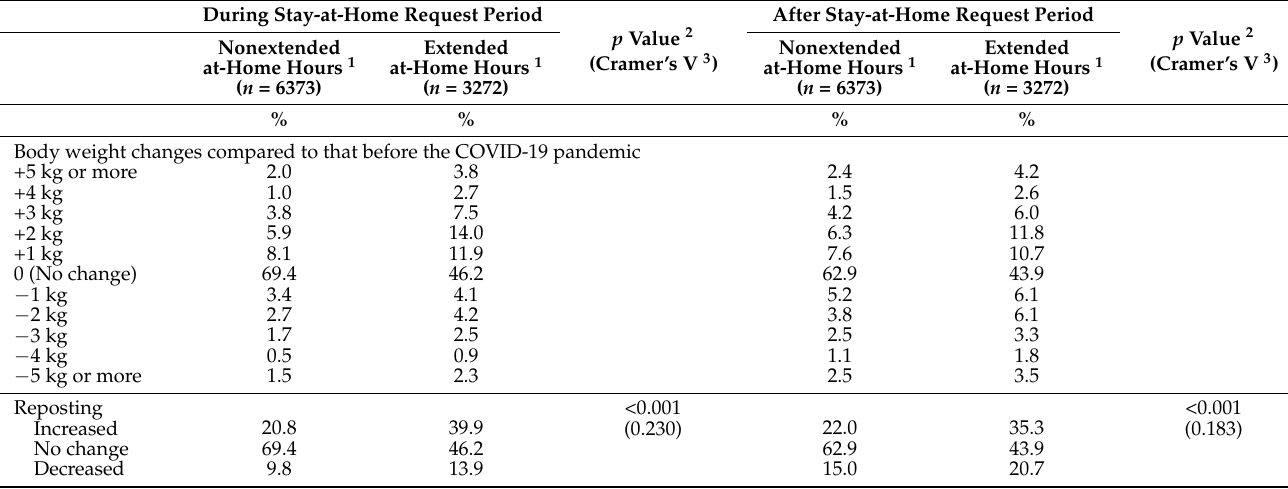
Table 5. Changes in body weight during and after stay-at-home request period according to changes in at-home hours during the stay-at-home request